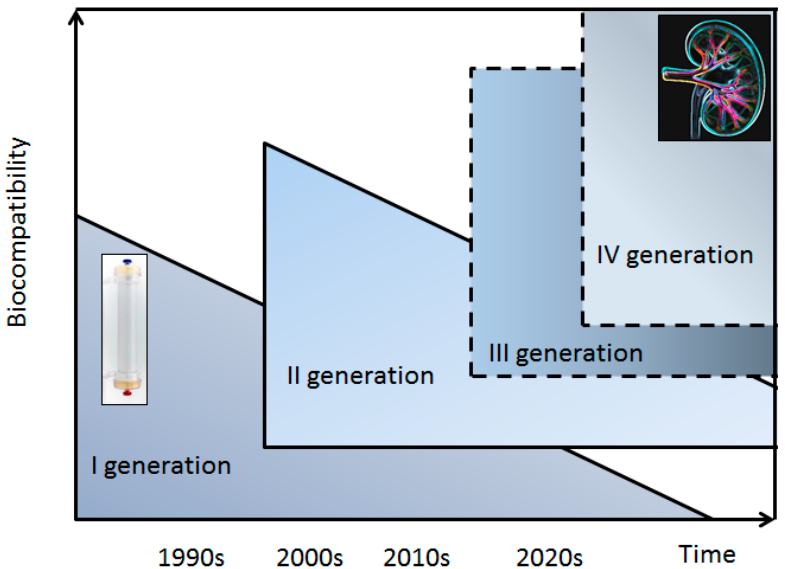
Figure 1. Evolution over time of biomaterials for hemodialysis membrane. Solid lines represent the material generation currently available in Hemodialysis (HD), dashed lines are used for material generation which are not presently available.